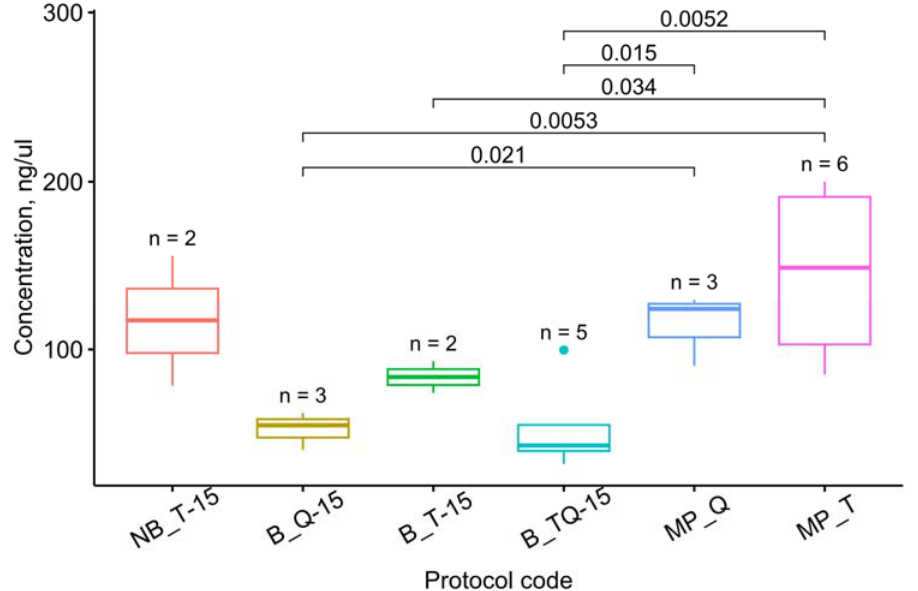
Figure 3. Concentrations for the methods that yield the average RIN values of >5. The letters up to “_” denote the grinding method: MP–mortar and pestle, NB–Tissue Lyser without buffer, and B–with buffer. The following letters denote the isolation protocol: T–TRIzol, Q–RNEasy Plant Mini Kit, and TQ–a combination (Table 1). The number after “-” denotes the grinding time on the Tissue Lyser in seconds. The letter n marks the number of samples used for each method. The t -test p -values are given for each pair of methods discussed in the text. Dots represent outliers.